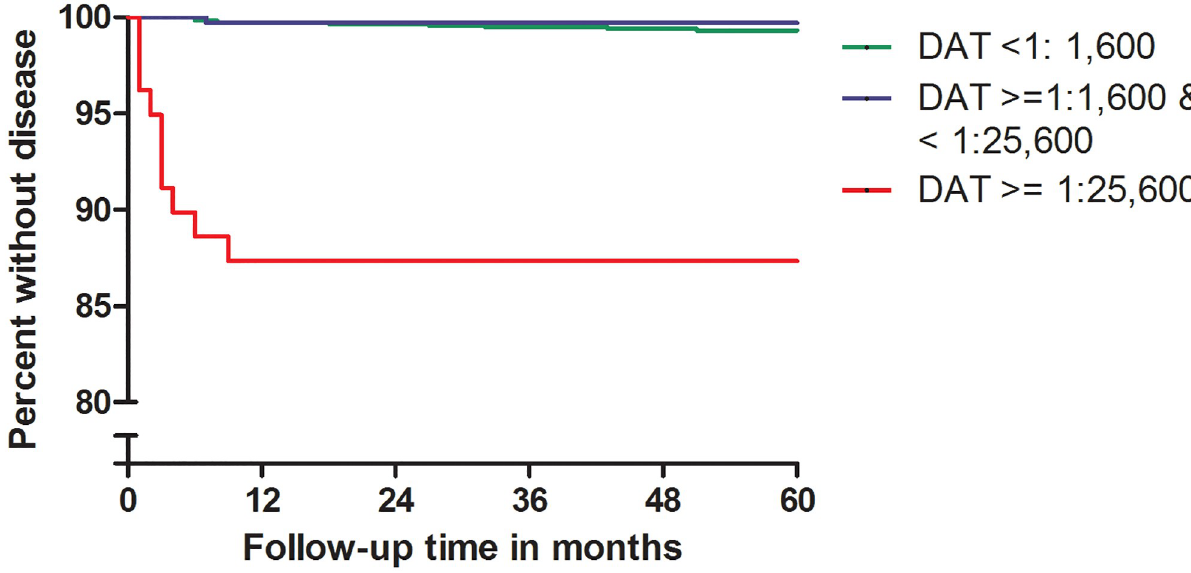
Fig 1. Risk of progressing to disease as a function of initial DAT titer.